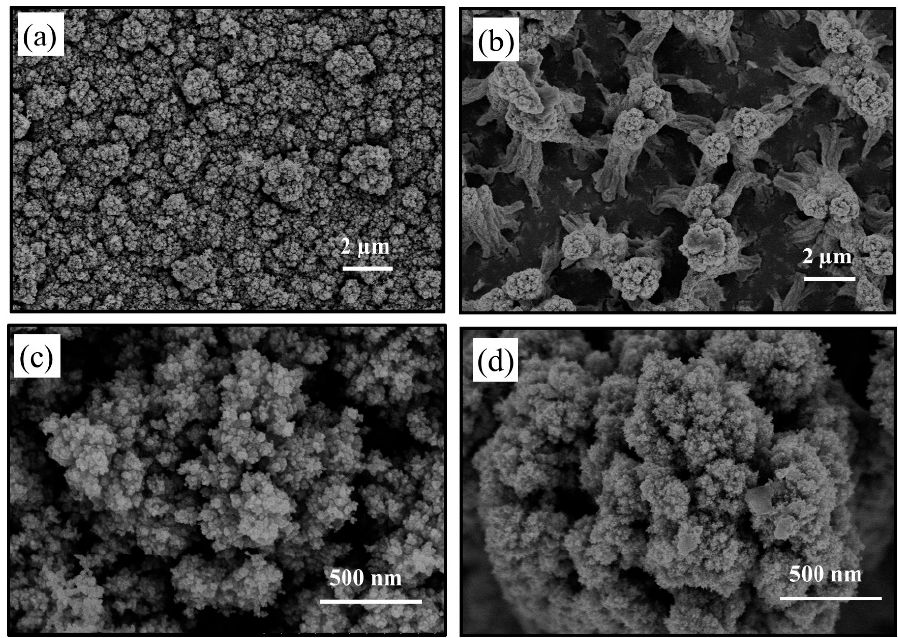
Figure 7. SEM images of ( a ) and ( c ) original sample, ( b ) and ( d ) plasma treated sample at 80 W.